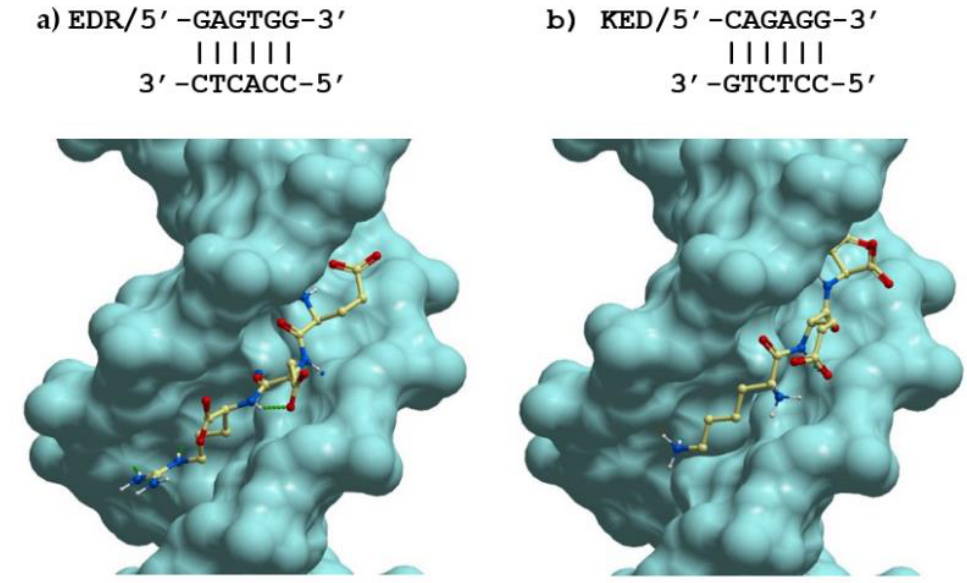
Figure 11. Lowest energy structures of complexes of the tripeptides ( a ) EDR and ( b ) KED with their best-fit dsDNA receptors in classic B-form.